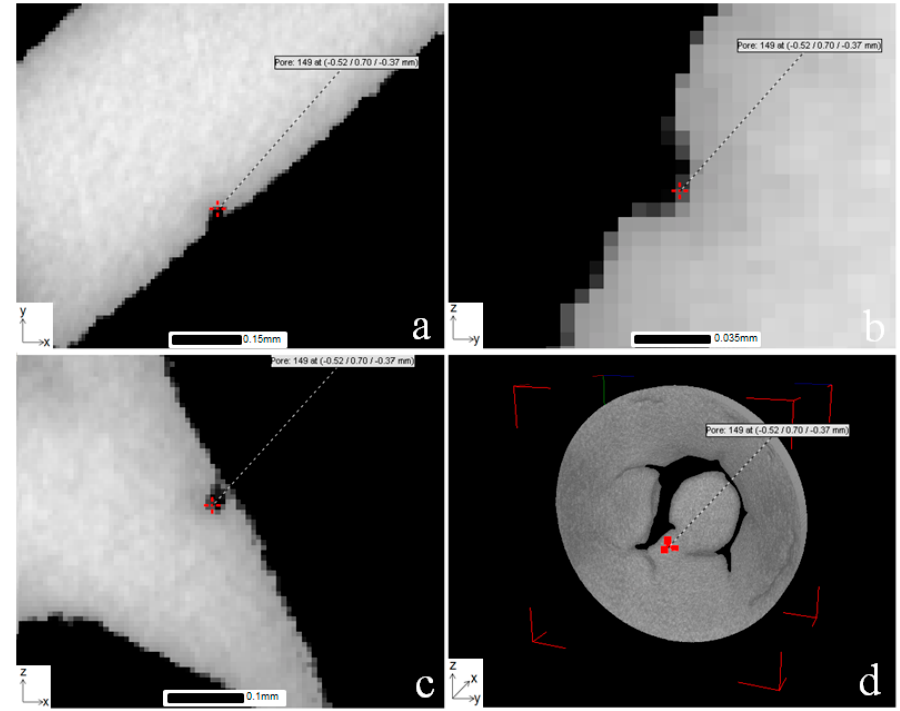
Figure 17. VG Studio representation of a surface breaching pore within the bulk material of the fractured EBM sample in ( a ) z direction; ( b ) x direction; ( c ) y direction and ( d ) 3D volume render of the isolated deformation region.